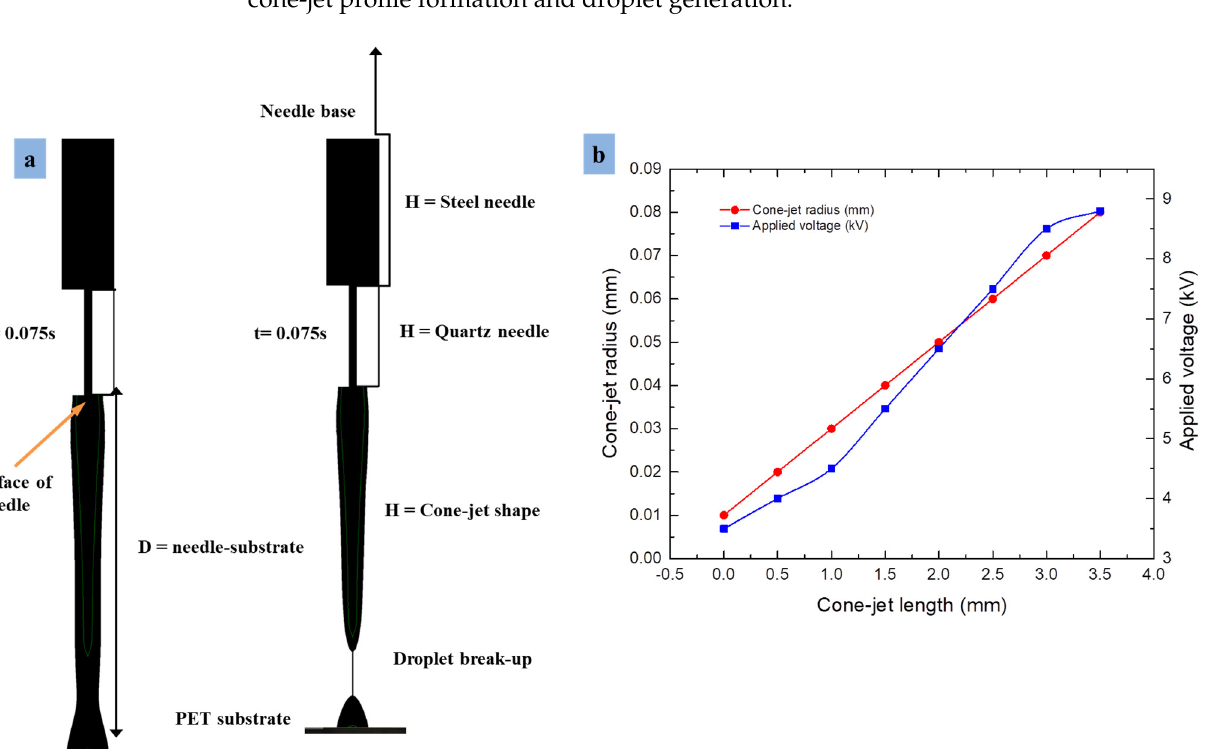
Figure 10. Different-sized microdroplets generated at higher flow rates of ( a ) 5.6 × 10 − 7 m 3 s − 1 and ( b ) 3.4 × 10 − 6 m 3 s − 1 .